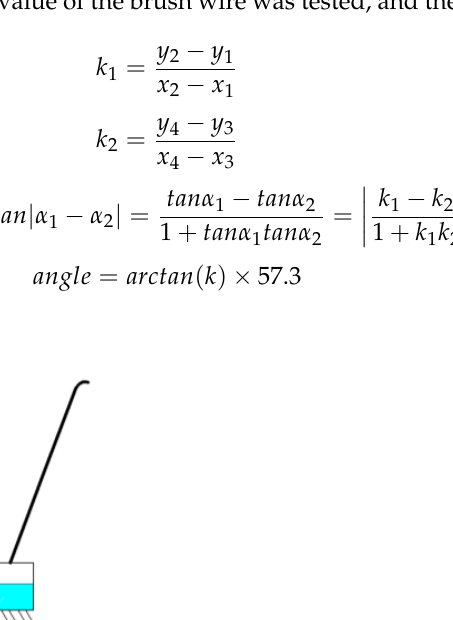
Figure 13. Principle diagram of brush wire angle measurement.